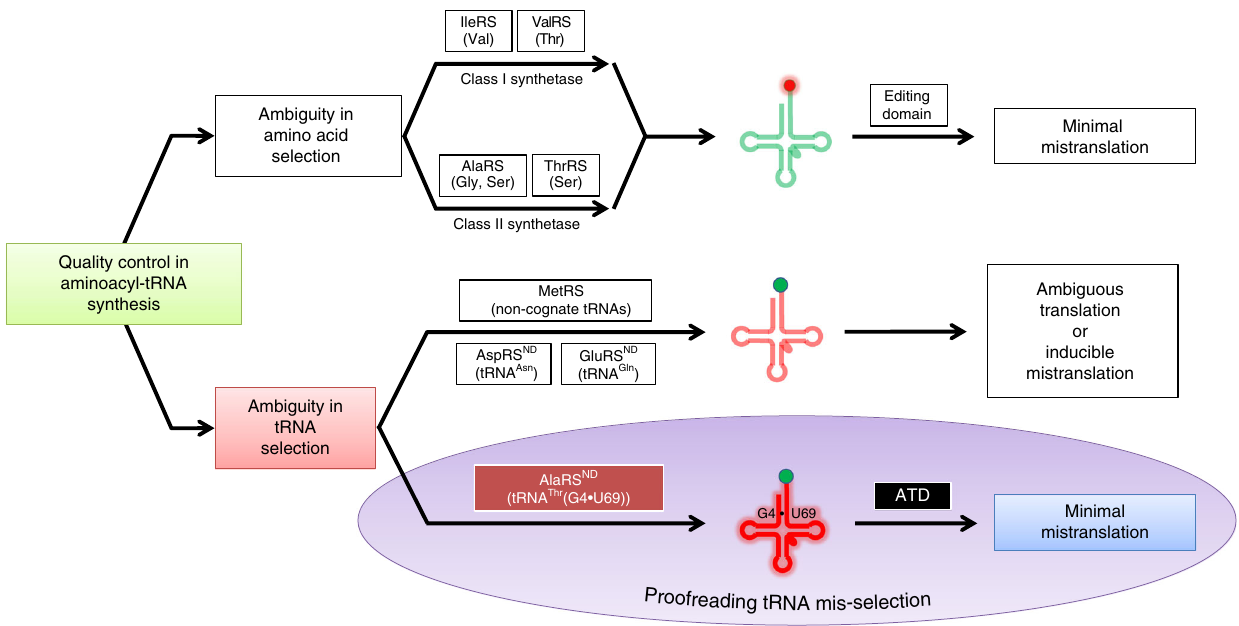
Fig. 8 ATD is a unique and dedicated proofreading factor that recti fi es a critical tRNA selection error. Model for mis-selection and consequent misacylation of tRNA Thr (G4 (cid:129) U69) with L -alanine by AlaRS ND , and its subsequent proofreading by ATD. Cognate and non-cognate tRNAs (clover leaf model) are colored in green and red, respectively. Likewise, cognate and non-cognate amino acids (circle) are rendered in green and red,